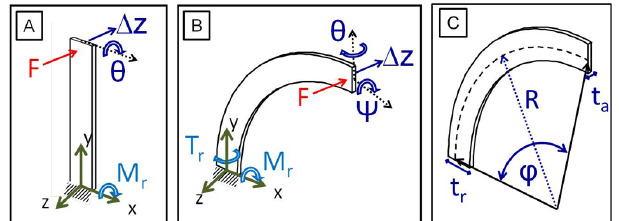
Figure 2. (A) Straight-beam mechanics, F is the load on the beam, M r is the resulting bending moment, ∆ z is the displacement along the z-axis, and θ is the parasitic rotation about the x-axis. (B) Curved-beam mechanics, highlighting the added twist, ψ , and torque, T r and (C) Curved-beam parameters. R represents the radius of curvature, φ is the sweep angle, t r is the thickness of the beam in the radial direction, and t a is the thickness in the axial